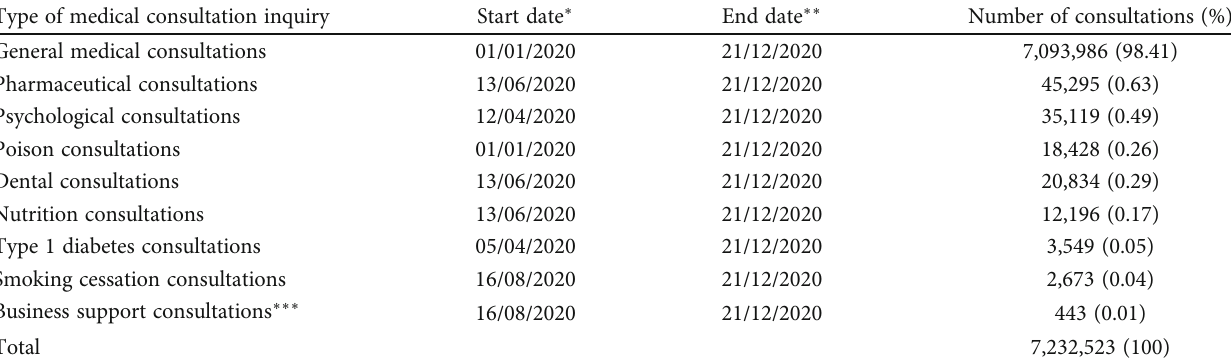
Table 1: The number and types of consultations received by 937-Call Center service in 2020.